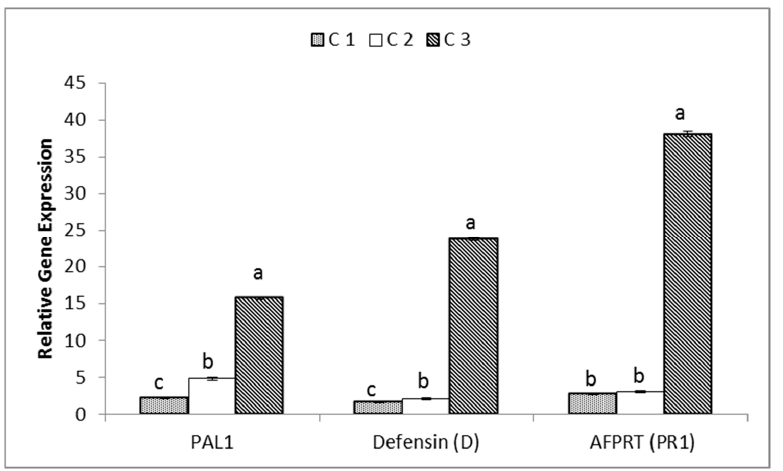
Figure 6. Relative gene expressions for PAL1, defensing (PR-12) and AFPRT (PR-1) genes in C. gileadensis accessions in KSA. Bars with different letters indicate significant differences between accessions, expressed as the mean of three replicates ± SDs.